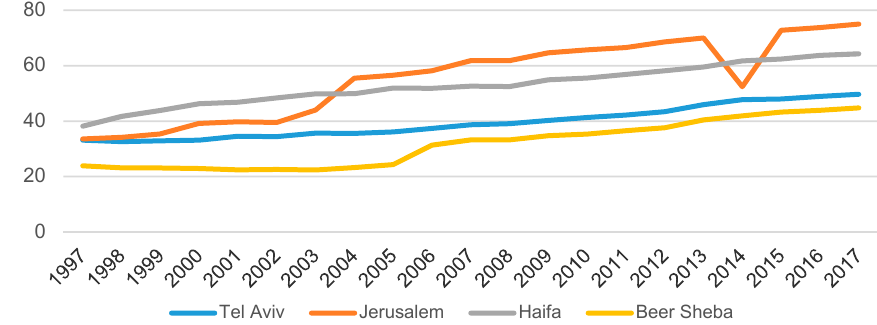
Figure 1. The average cost per square meter (property tax rate) for residential property in 1997–2017. Explanation: X-axis = timeline, Y-axis = average cost per square meter of residential property (Blue—Tel Aviv; Orange—Jerusalem; Grey—Haifa; Yellow—Beersheba). Source: Own calculations based on the Central Bureau of Statistics in Israel (CBS) data.